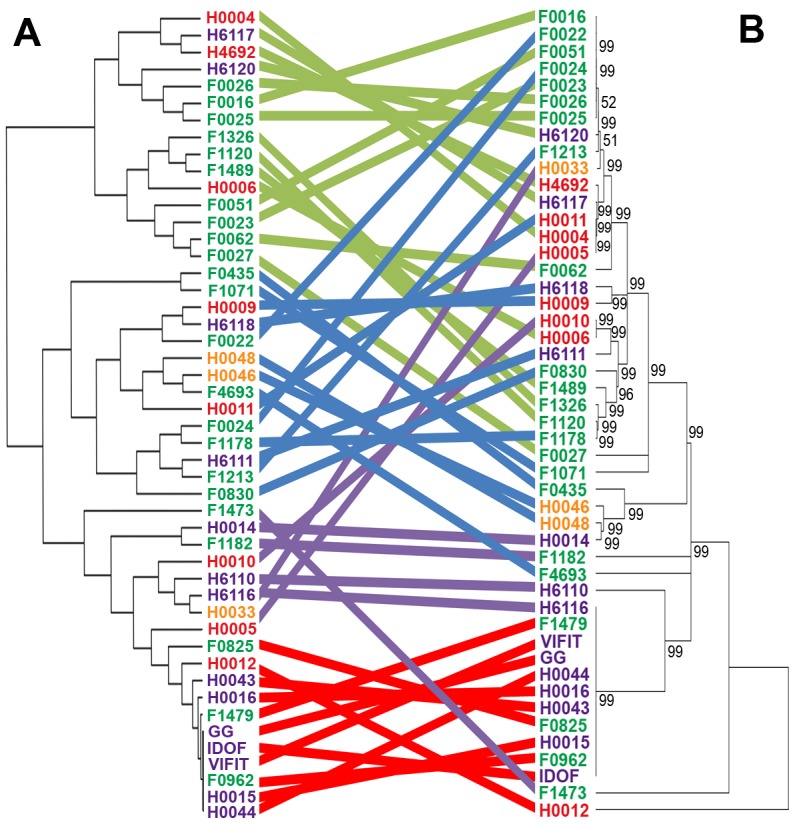
Comparison of hierarchical clustering and phylogenetic tree of a selected set of L. rhamnosus strains.Both hierarchical clustering (panel A) and phylogenetic tree (panel B) were performed on all L. rhamnosus strains, excluding isolates from unspecified or clinical origins. Coloured strings connecting the same strains of both trees aims at highlighting the degree of similarities between both tree methods [78], [79].